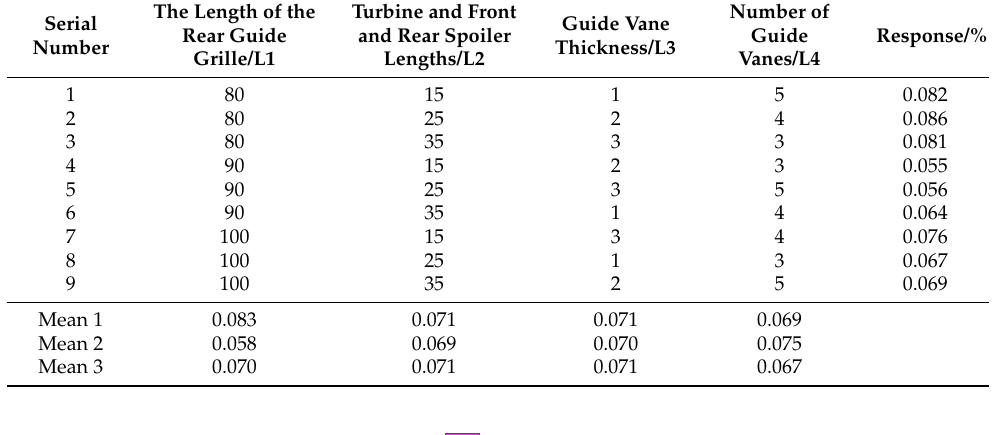
Table 8. Orthogonal experiment results and mean.